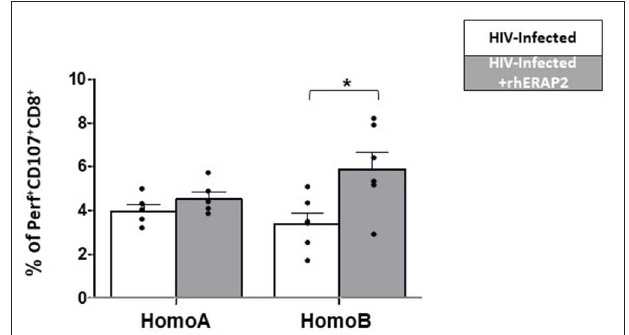
FIGURE 4 | The percentage of perforin-expressing CD107 + CD8 + cells was increased in in vitro rhERAP2-treated HIV-1 infected PBMCs. Percentage of perforin-expressing CD107 + CD8 + cells in rhERAP2 untreated (white bars) or treated (gray bars) PBMCs from HomoA and HomoB subjects 3 days after in vitro HIV-1 infection. Mean values and SEM are shown. * p <